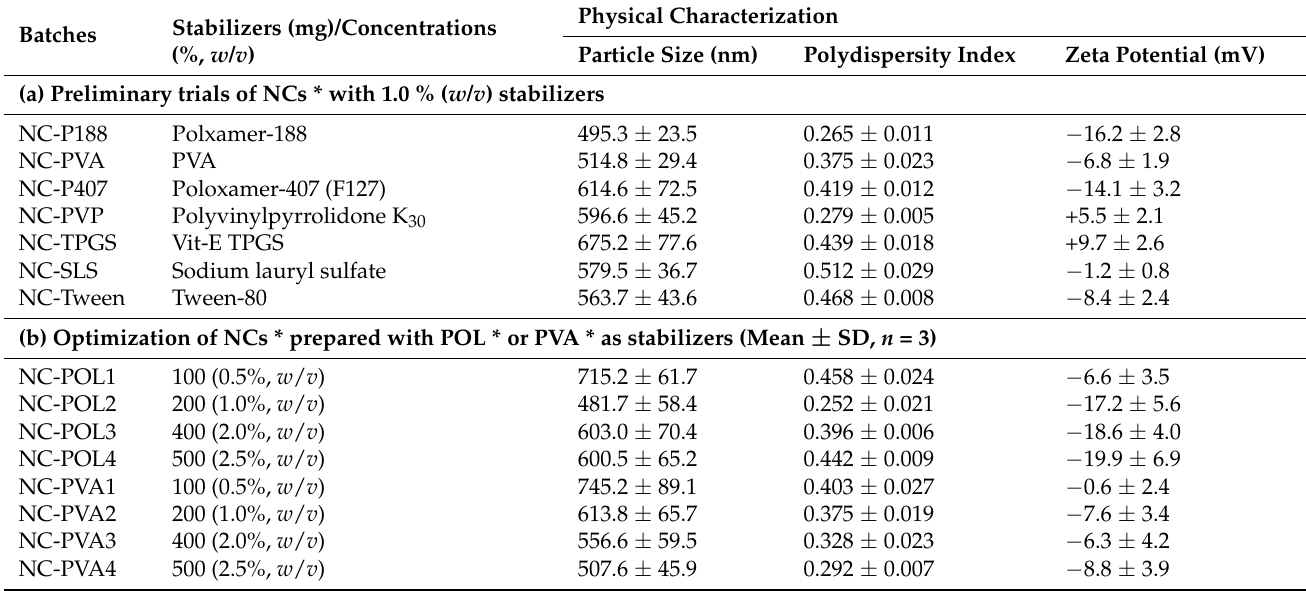
Table 1. Physical characterization of the preliminary batches of nanocrystals prepared (using 10 mg